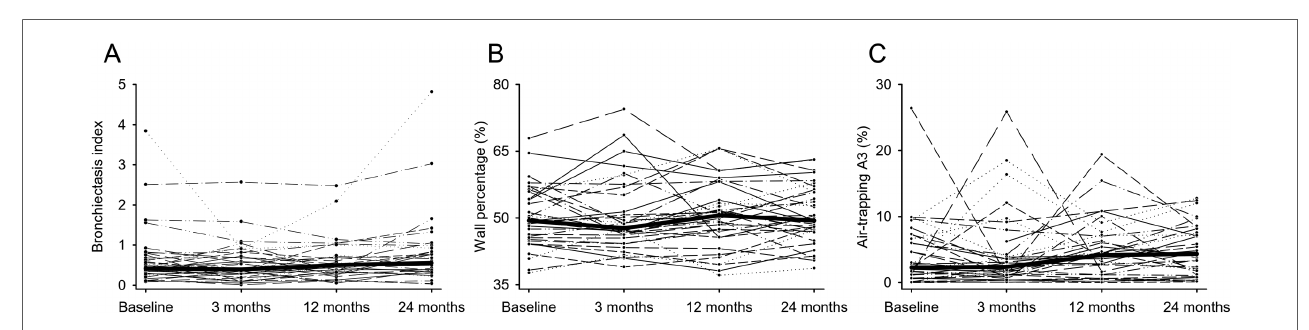
FIGURE 3 QCT measures over two years, the thin lines connect the values of the individual patients ( N =36) over time, the thick lines connect the median values. ( A ) The airway parameter bronchiectasis index (BEI) changed over two years from 0.41 to 0.54 ( P =0.156). ( B ) WP 5 − 10 remained stable between baseline and 24 months ( P =0.248). ( C ) The air trapping parameter (A3) showed high variability at all time points, but increased the median A3 from 2.26% to 4.35% ( P